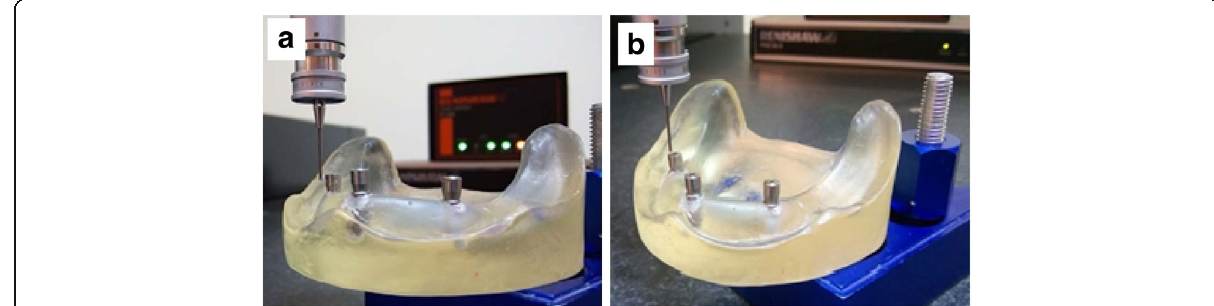
Fig. 6 a Measuring the outer diameter. b Measuring the upper